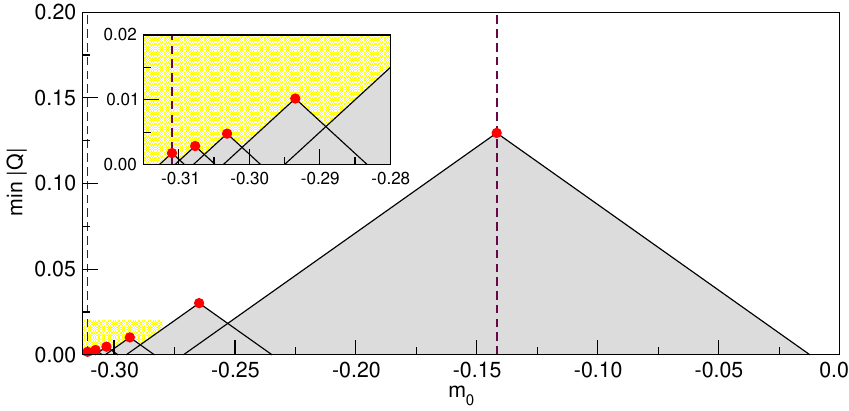
Figure 8 . Smallest eigenvalue of | Q | for up-type quarks as a function of the valence mass m 0 (red points), calculated on a representative configuration ( C380a50b324 ensemble). Proposition 1 implies that | Q | has no eigenvalues in the grey areas. In particular, no eigenvalue of Q crosses zero between the up-quark mass (left dashed vertical line) and the charm-quark mass (right dashed vertical line). One can see that we are able to flow the lowest eigenvalue across two orders of magnitude in only six steps. The inset is a zoom-in of the yellow